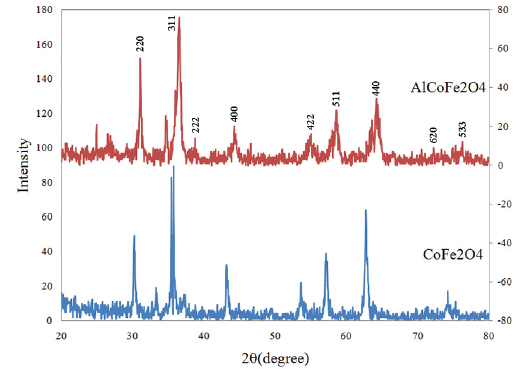
O and Al-dopped CoFe 2 4